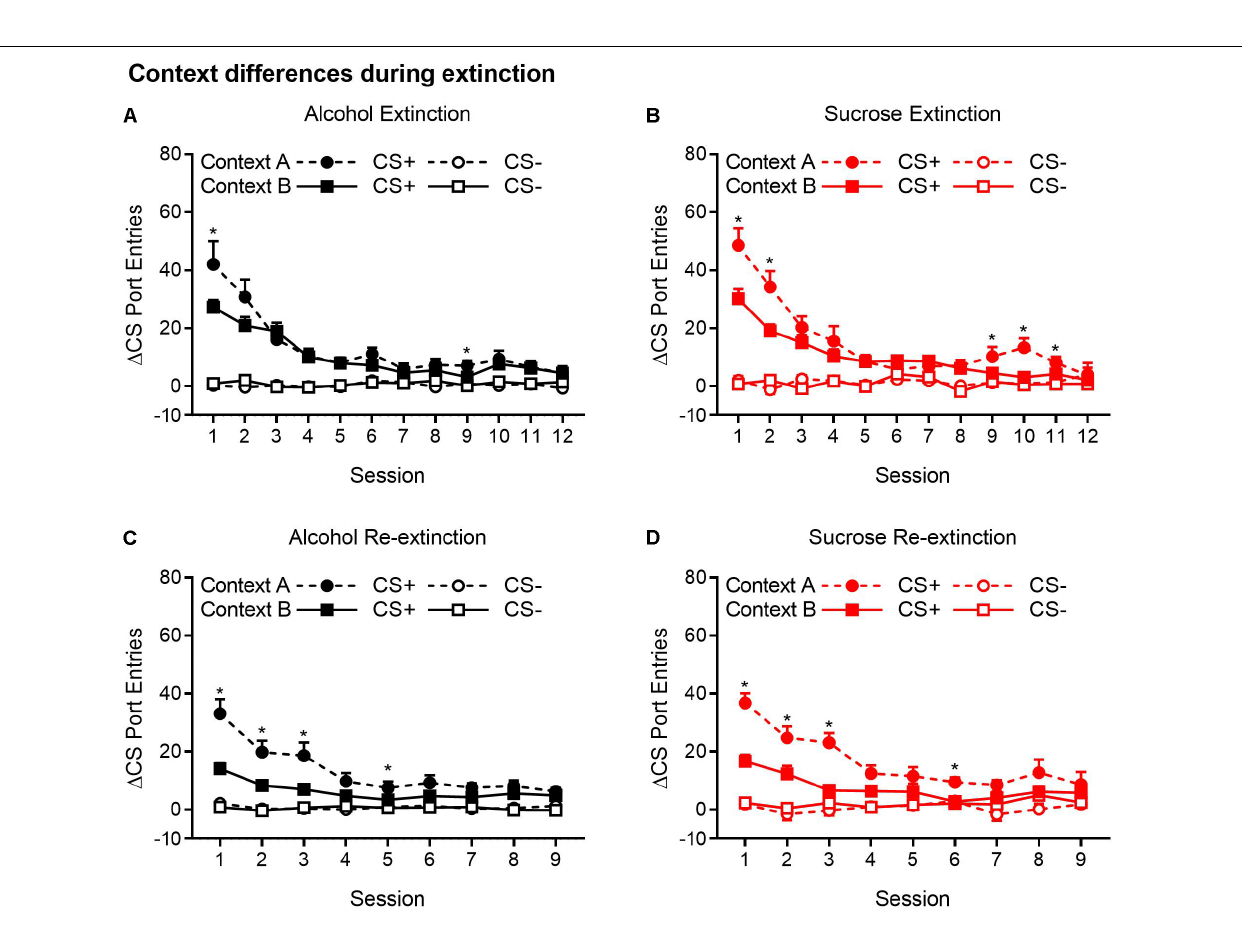
FIGURE 4 | CS+ port entries were transiently elevated during extinction in context A compared to context B. Port entries across 12 extinction sessions prior to test 1 that occurred in (A) alcohol-trained rats ( n = 12) and (B) sucrose-trained rats ( n = 11). After the first renewal test, rats were retrained for 5 days and subjected to 9 days of re-extinction. Port entries are shown for (C) alcohol-trained and (D) sucrose-trained rats. All data are means ± SEM. * p < 0.05, Bonferroni-corrected post hoc comparisons for CS+ responding between the two extinction contexts.